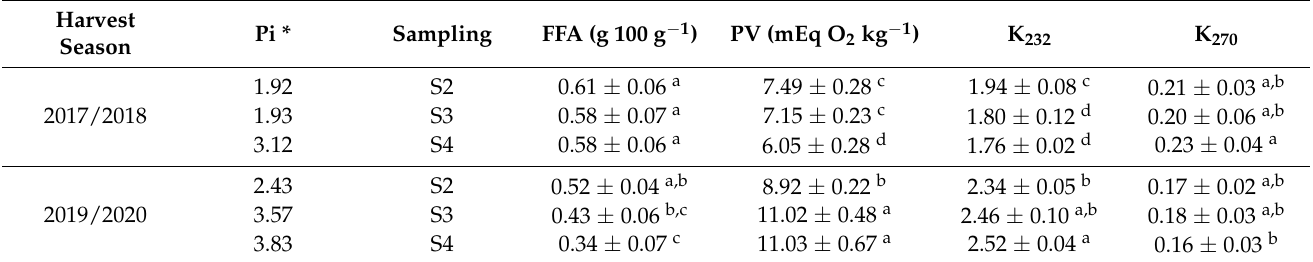
Table 2. Basic quality parameters of the Oliva Rossa VOOs extracted during fruit ripening in two different harvest seasons (mean ± SD, n =